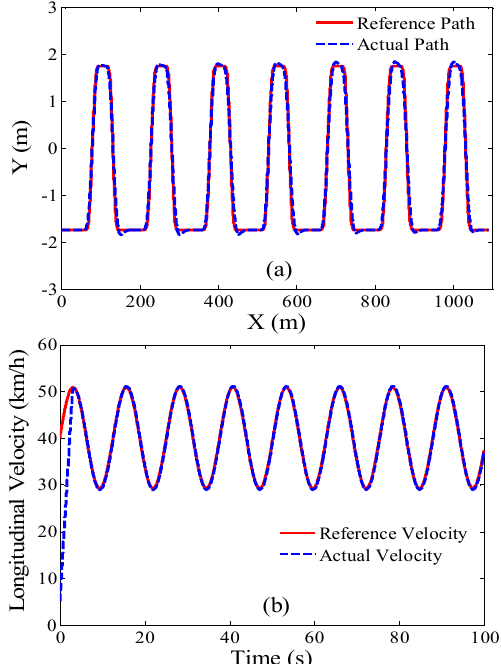
Figure 8. Tracking results of the consecutive DLC test: ( a ) path tracking result; ( b ) speed following result.